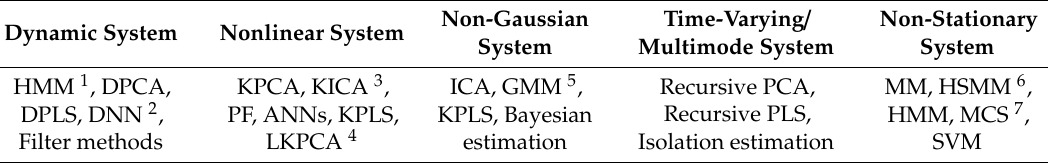
Table 1. Systematic categorization of data-driven FDD